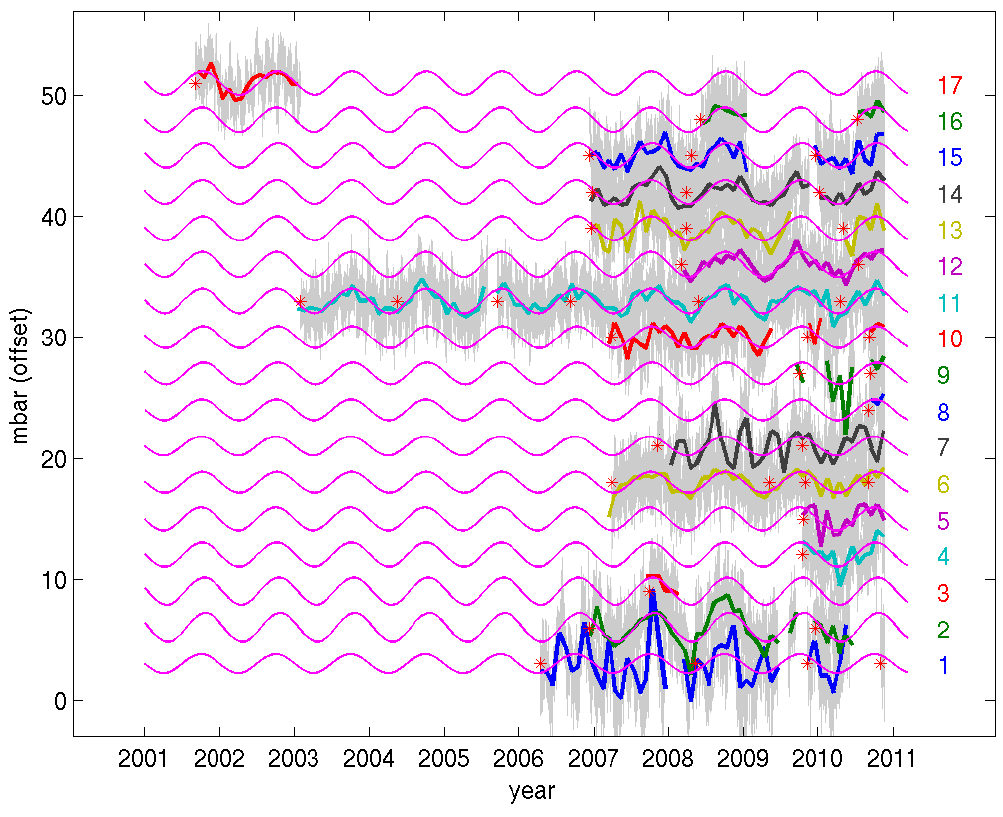
Figure 10. Monthly mean bottom pressure at each site after removing ocean dynamics (from ECCO), tides, atmospheric pressure; vs. site- adjusted annual mass p ANN m calculated from simultaneous fit to bottom-pressure recorder data using ECCO with GLDAS-1 (peak of noise distribution). Bottom pressure before averaging is plotted in grey at each site. The y -axis offset between sites is